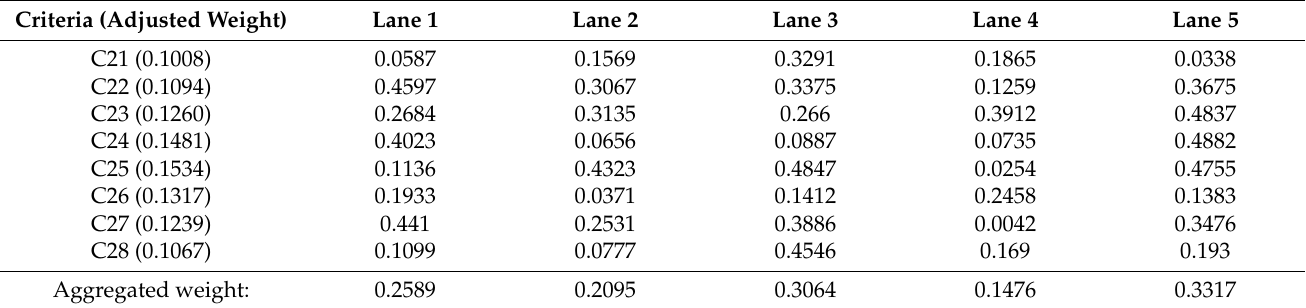
Figure 8. Graphical illustration of the credal ranking of the eight criteria in the shipping lane selection problem. Table 5. Aggregated result summary of the carrier selection problem.